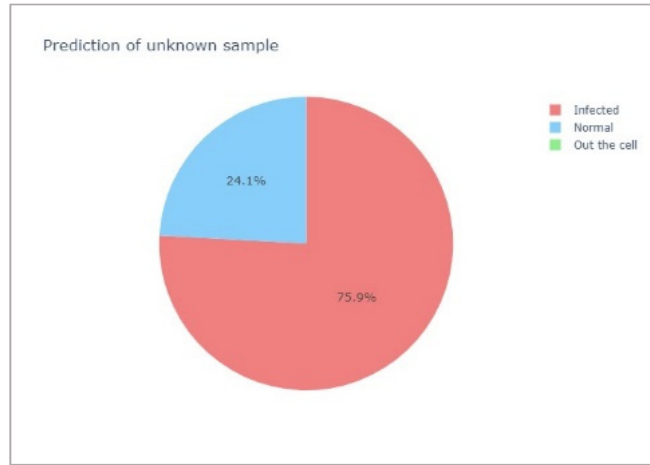
Figure 10. An example of a prediction pie chart. Table 3. Prediction results of blind samples. Sample